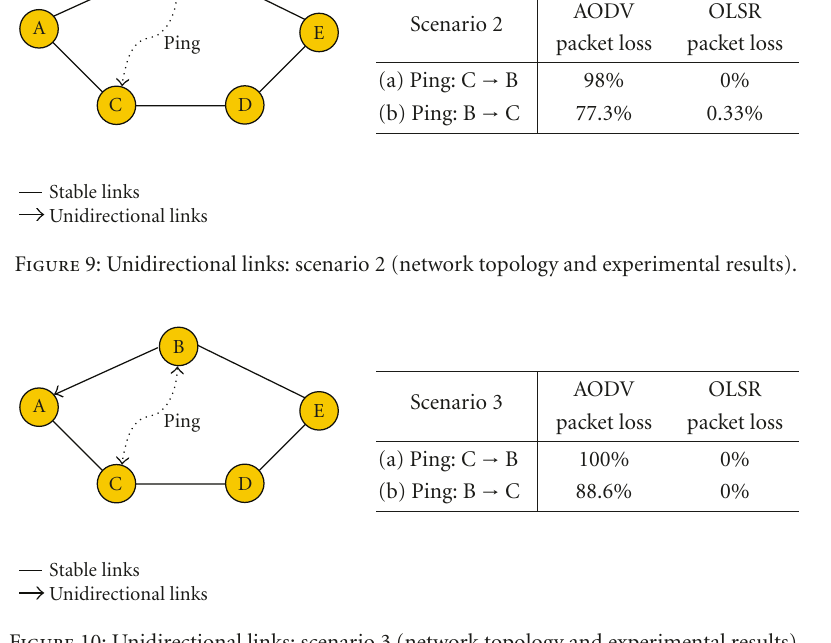
Figure 10: Unidirectional links: scenario 3 (network topology and experimental